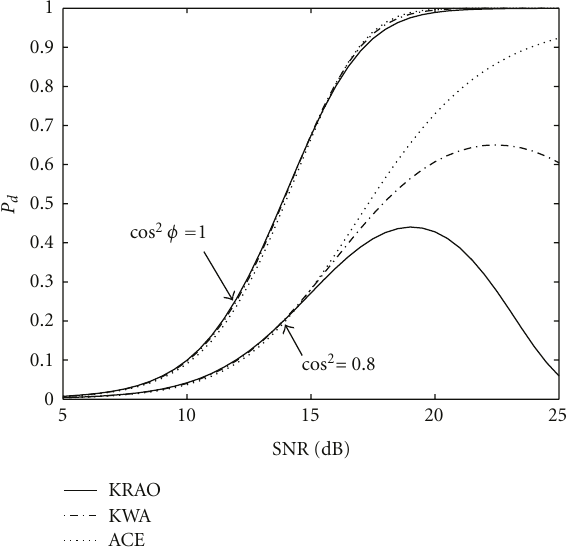
Figure 4: P d versus SNR for the KRAO with ρ = 0 . 9, the KWA with γ = 0 . 8, and the ACE, N = 16, K =